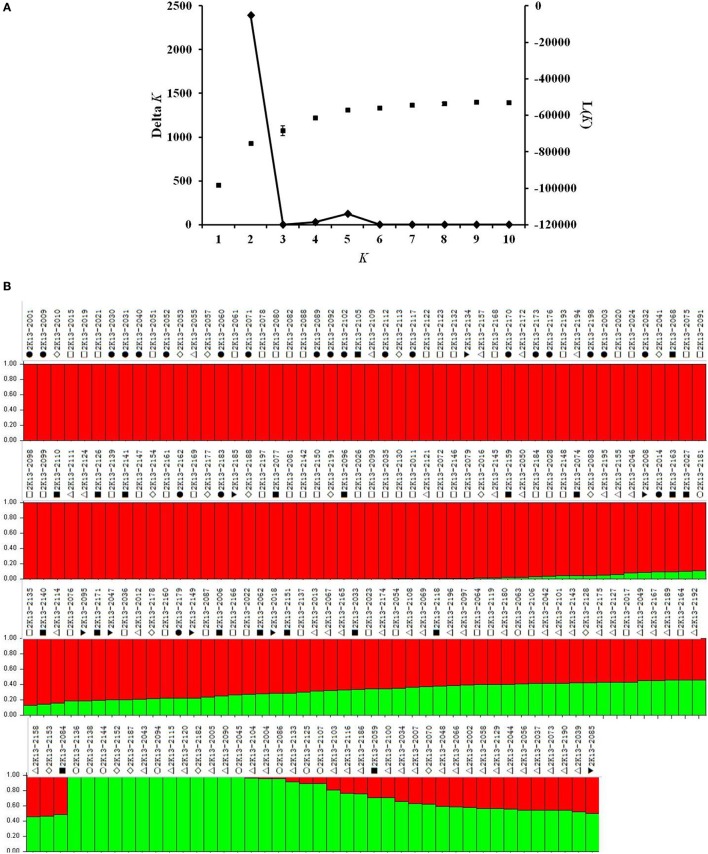
(A) L(K) and ΔK plots derived from the InDel data. ΔK is calculated as the mean of the absolute values of L”(K) averaged over 20 runs divided by the standard deviation of L(K). ΔK = m(|L”(K)|)/s[L(K)], which expands to ΔK = m(|L(K+1)-2L(K)+L(K-1)|)/s[L(K)]. L(K) is the Pr(X|K) referred as “Ln P(D)” in the output of STRUCTURE software. (B) Population structure estimates based on 547 InDel markers distributed across the tomato genome. The area of two different colors (Red and Green) illustrates the proportion of each subpopulation based on these InDel markers. Symbols represent accessions from different species or market class of tomato: ○ Solanum pimpinellifolium, ◊ S. lycopersicum var. cerasiforme or cherry tomato, ■ Latin American Cultivar, □ Fresh-market, Δ Processing, • Vintage, ▼ Unknown type. The accession of each plot number can be found in Table S1.